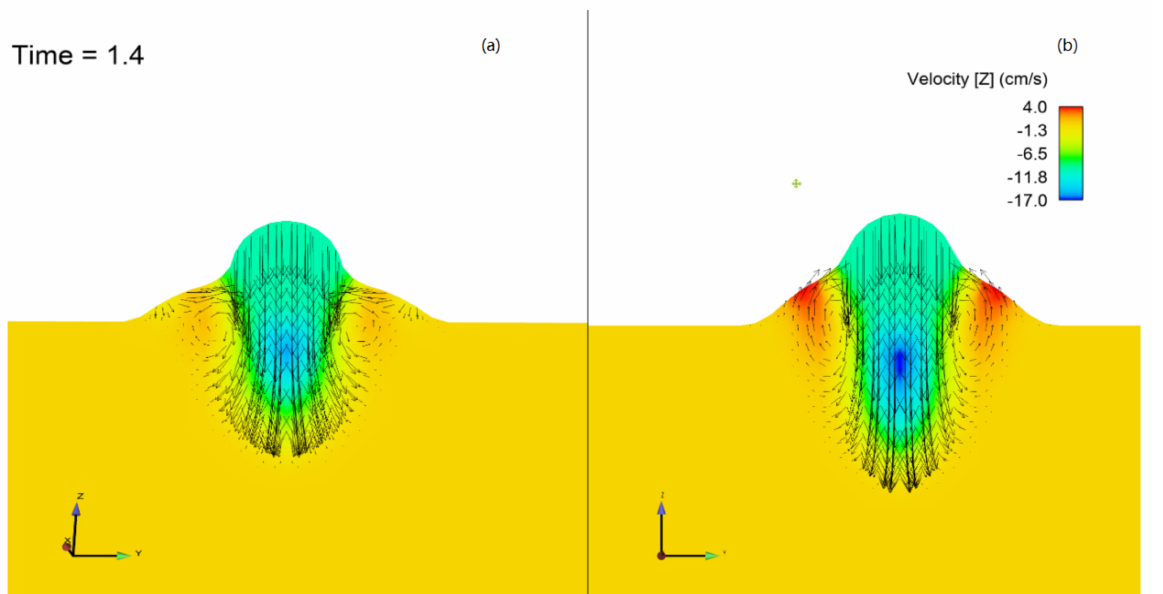
Figure 13. Weld pool velocity distribution in the x - z plane for identical heat input for ( a ) 420 ppm oxygen concentration and ( b ) 500 ppm oxygen concentration. The velocity in the z -direction is indicated by the color, and the length and direction of the